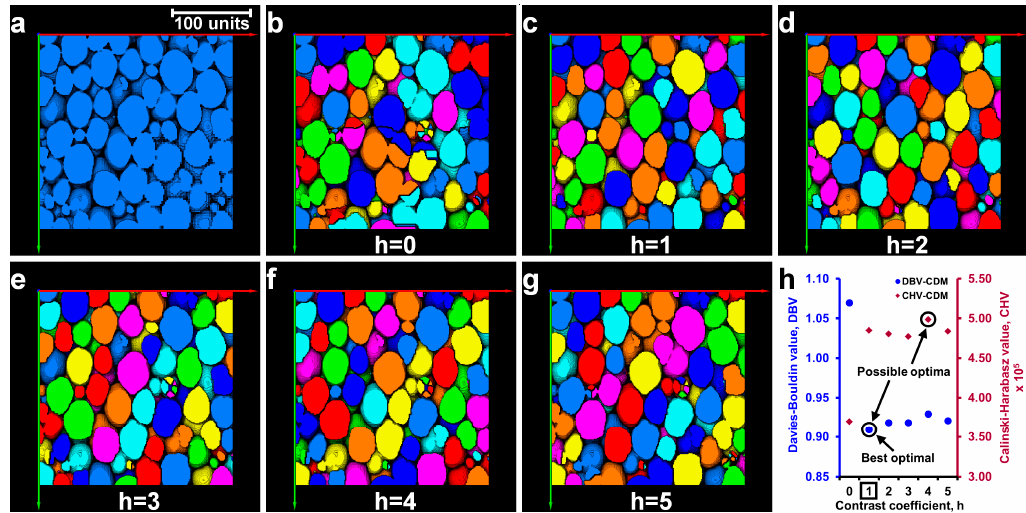
Figure 3. Determination of the optimal contrast coefficient, h, for “foam.am”: ( a ) binary volume; ( b – g ) separation results for different h -values ( h = 0 to 5) with the Chamfer distance map (CDM); and ( h ) cluster evaluation criteria values with the optimal h -value (square marked).